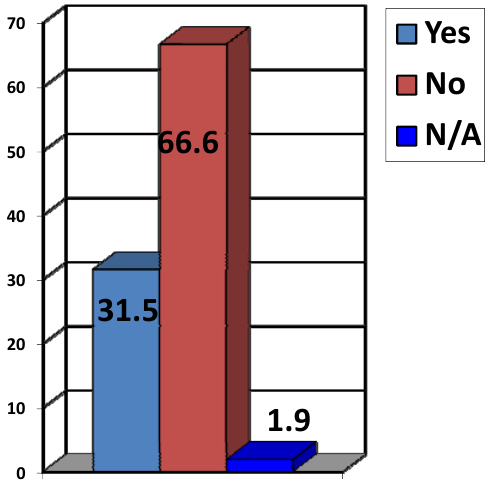
Figure 5. Did you contact the police in the last 12